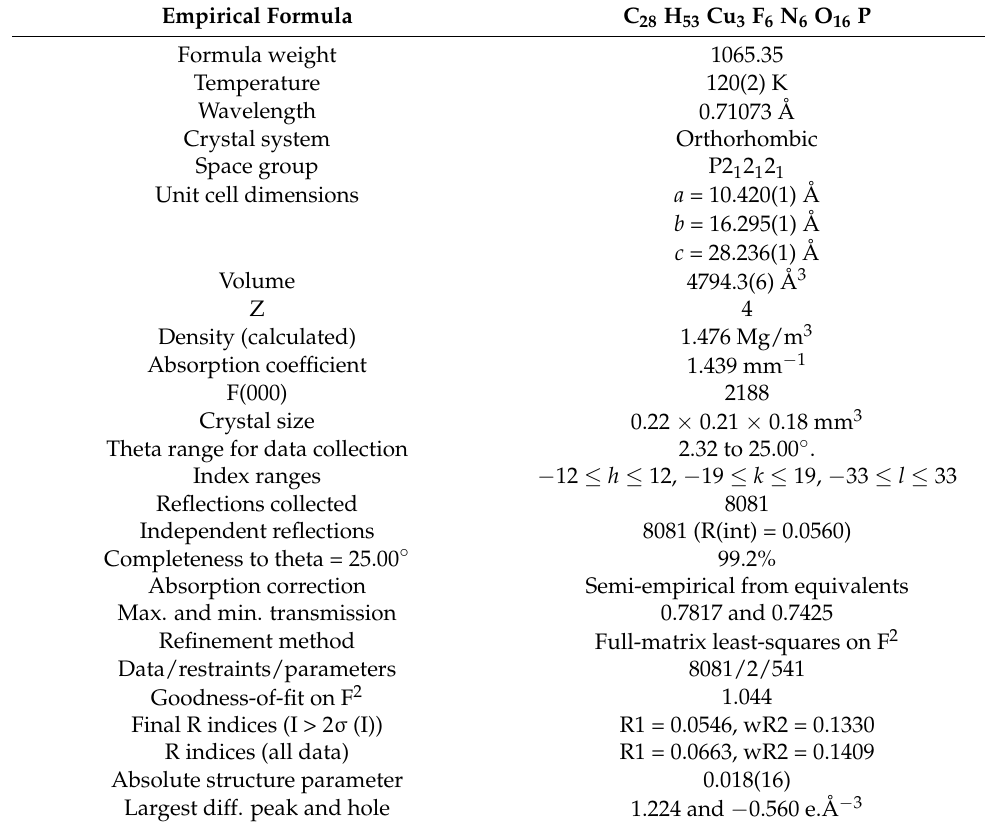
Summary of crystal data and